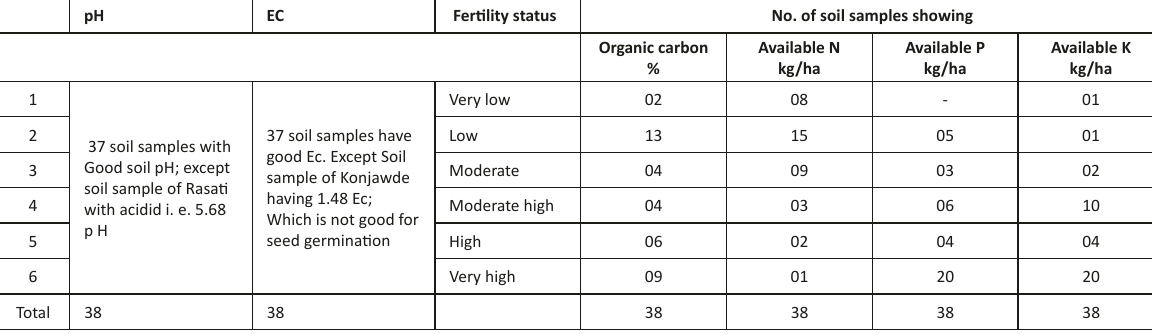
Organic carbon Available N Available P Available K % kg/ha kg/ha